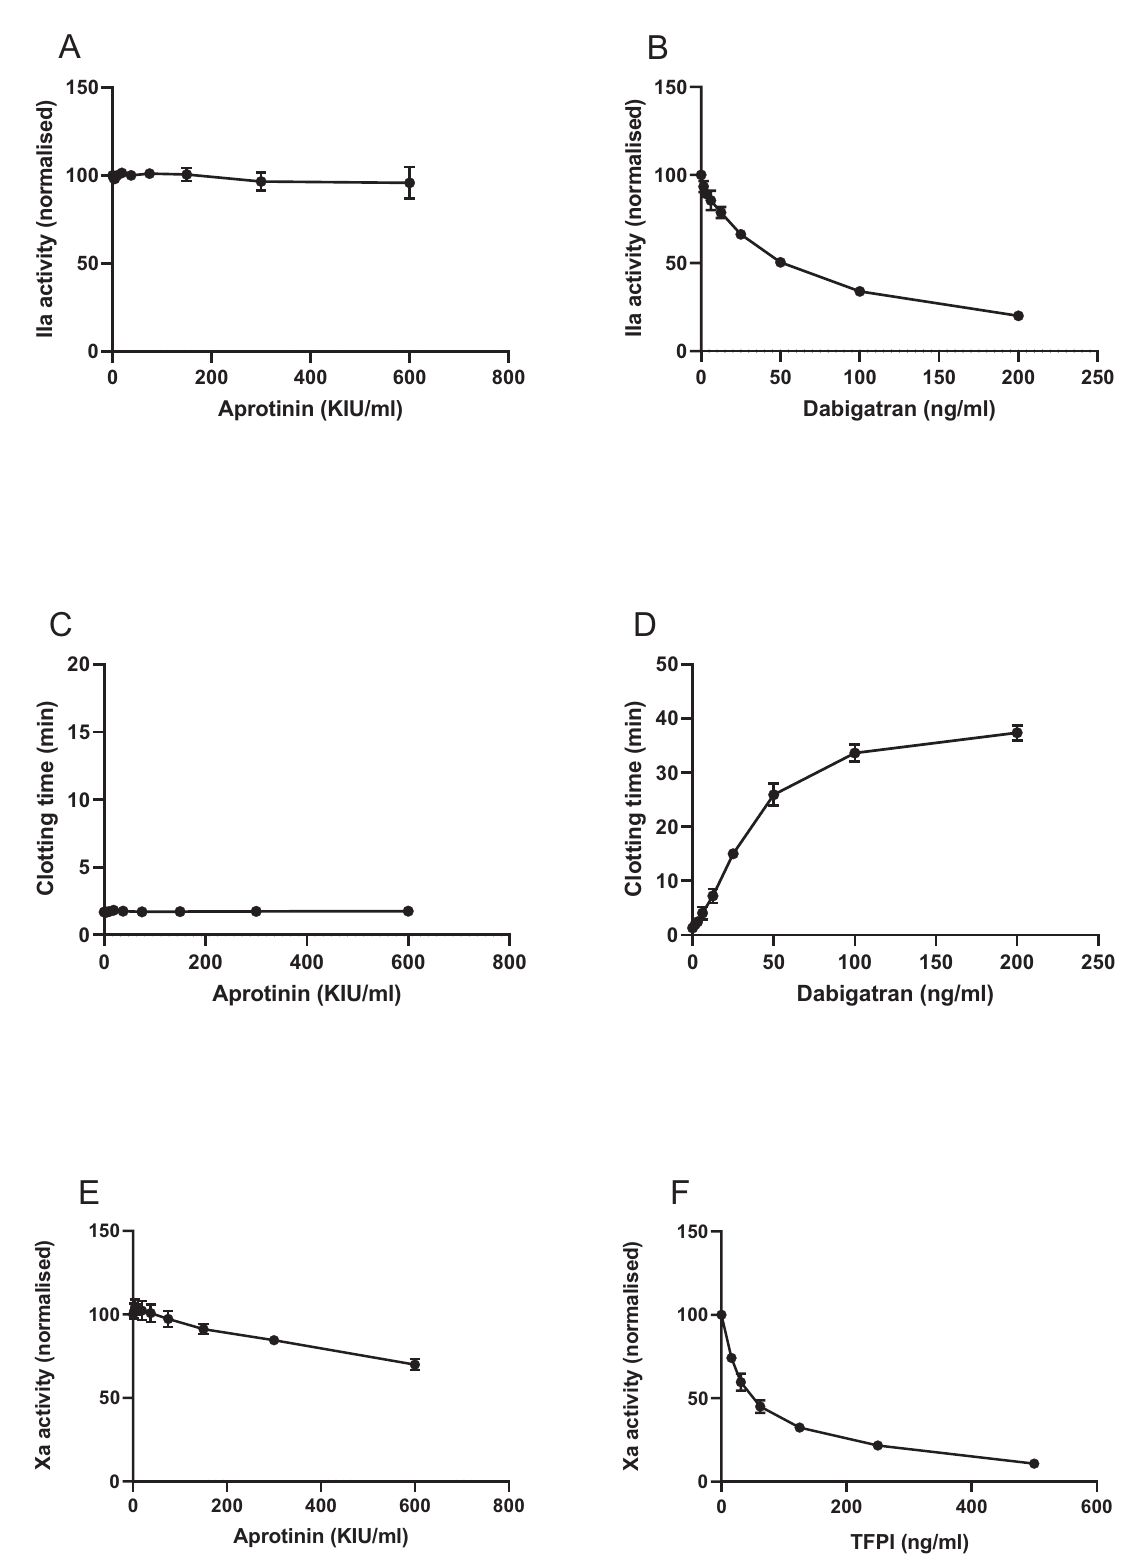
Fig. 7 Effects of aprotinin on thrombin and the tissue factor-factor VIIa complex. A and B : Aprotinin or dabigatran were added in increasing concentrations to puri fi ed thrombin after which thrombin activity was assessed using the chromogenic substrate S2238. C and D : aprotinin and dabigatran were added in increasing concentrations to puri fi ed fi brinogen, after which thrombin was added. Clot formation was monitored by turbidity measurements over time. E and F : Aprotinin or TFPI were added to the tissue factor-factor VIIa complex in the presence of factor X and factor Xa generation over time was assessed using a chromogenic substrate. Shown are mean values of 3 independent experiments. Error bars indicate standard deviations (but are not visible for the majority of data points as standard deviations were very low).